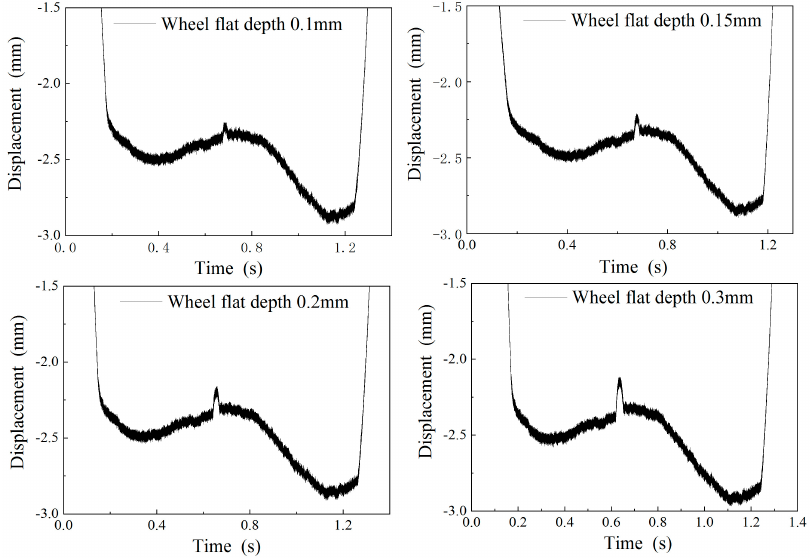
Figure 13. The measuring waveform of the simulated wheel flat. Table 1. Wheel flat measurement results.